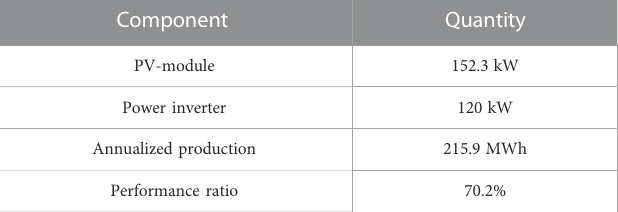
TABLE 12 Quantitative analysis of